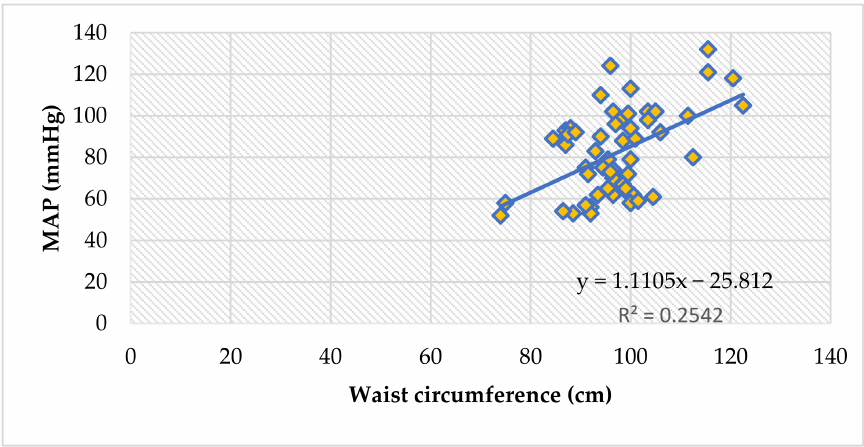
Figure 3. The correlation between mean arterial pressure and waist circumference, in all children (Spearman’s ρ = 0.42, p =